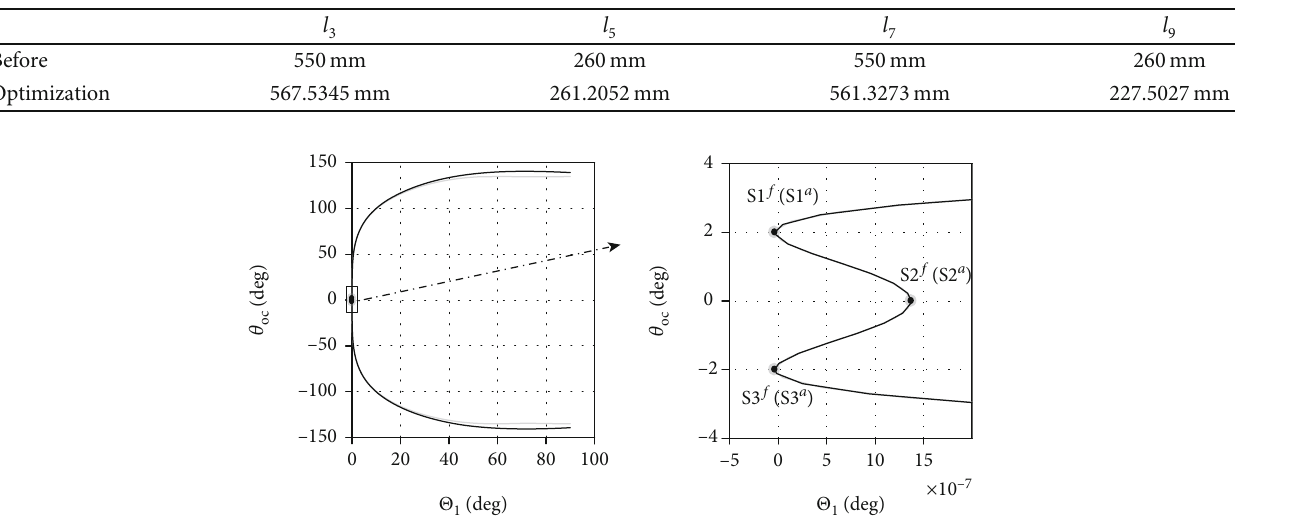
Table 2: Synchronous locking optimization results (other parameters).